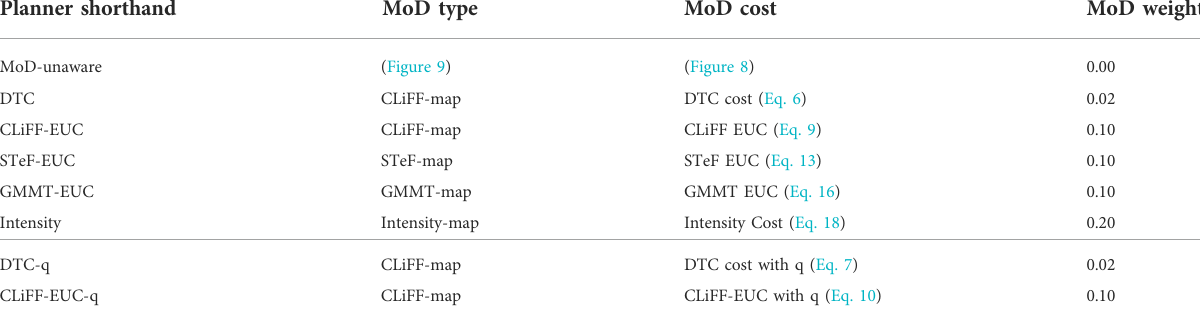
TABLE 2 Table showing planner shorthands, MoD-type, the MoD-cost function used and chosen values of w c for all planners used. Planner shorthand